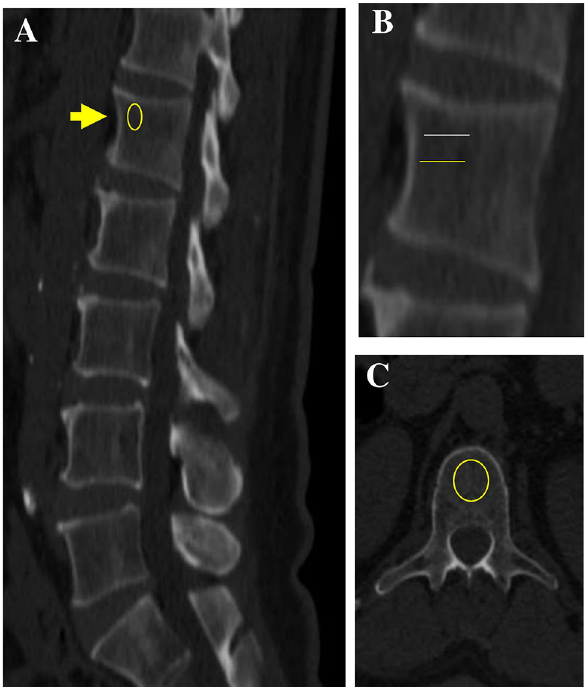
Figure 3. Example of unenhanced computed tomography (CT) images of the spine of a 59-year-old woman. ( A ) Bone window showing the first lumbar vertebra level (arrow) and oval yellow ring shows the ROI, ( B ) Magnified view of the first lumbar vertebra and region of interest. The yellow midline line matches the automated level; the white line reflects the standard manual level. ( C ) First lumbar vertebra axial image; oval yellow ring shows the region of interest. CT examination was performed at a constant peak voltage of 120